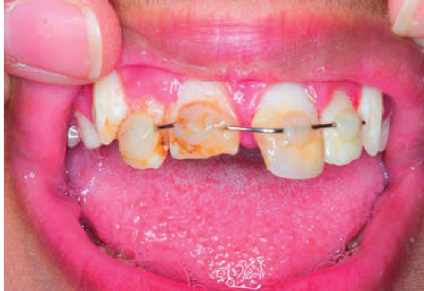
Figure 3: Splinting with a nonactive orthodontic wire and com- posite after surgical